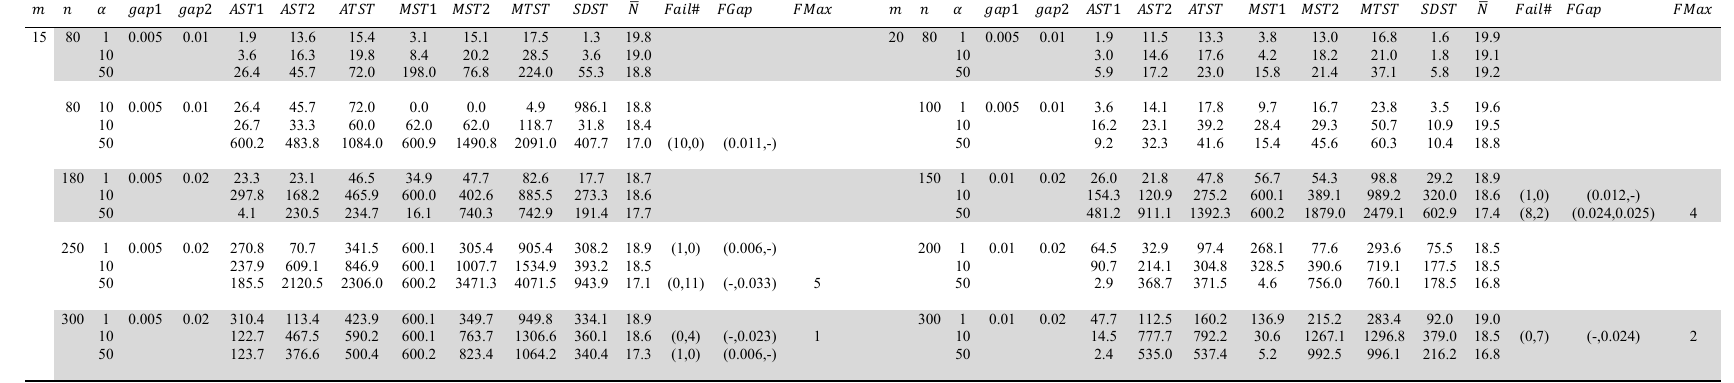
Experimental results of applying the MILP solution procedure for the problem instances with 15 and 20 machines 𝑚 𝑛 𝛼 𝑔𝑎𝑝 1 𝑔𝑎𝑝 2 𝐴𝑆𝑇 1 𝐴𝑆𝑇 2 𝐴𝑇𝑆𝑇 𝑀𝑆𝑇 1 𝑀𝑆𝑇 2 𝑀𝑇𝑆𝑇 𝑆𝐷𝑆𝑇 𝑁(cid:3365) 𝐹𝑎𝑖𝑙 # 𝐹𝐺𝑎𝑝